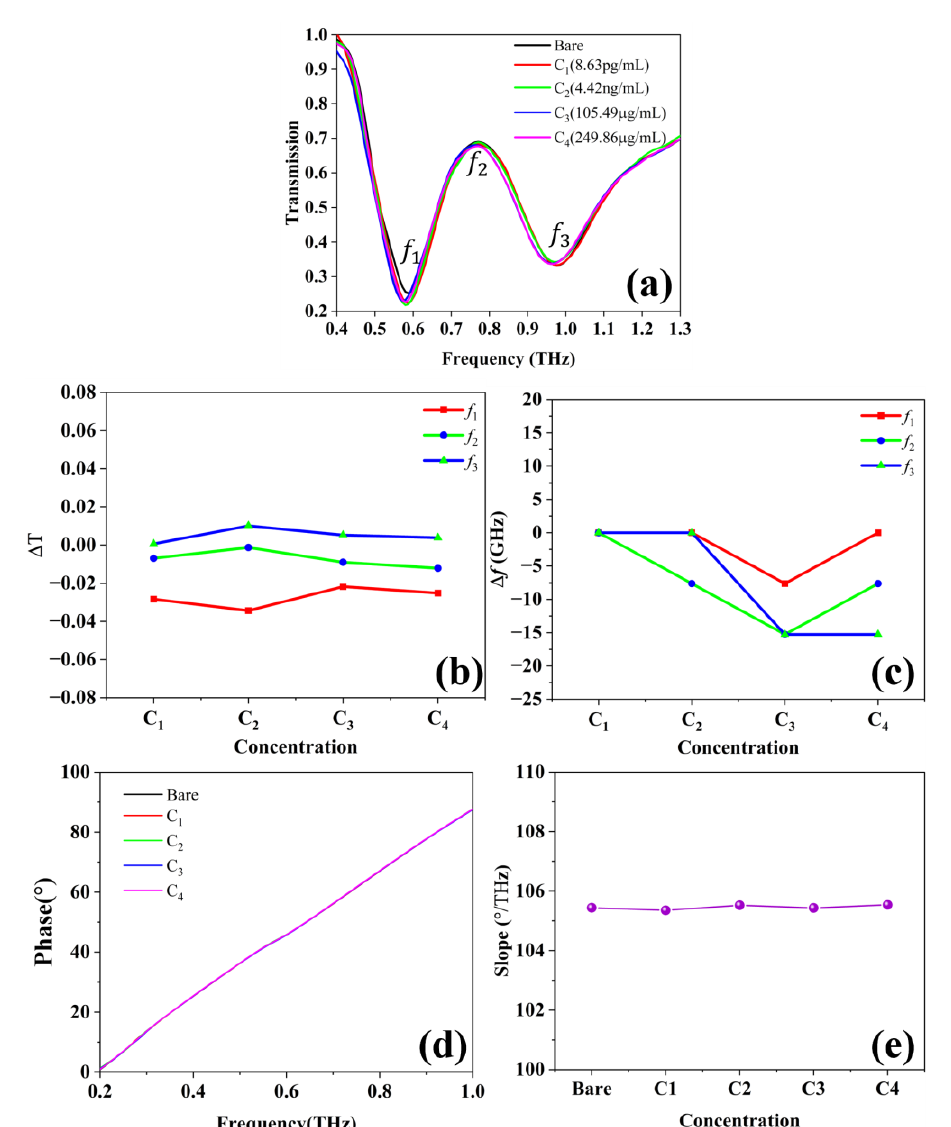
Figure 3. Experimental results of the control group. ( a ) Transmittance spectra of sensors with different concentrations of OVA. ( b ) The amplitude changes of the sensor under the influence of different concentrations of OVA. ( c ) The frequency changes of the sensor under the influence of different concentrations of OVA. ( d ) Phase spectrograms of different OVA concentrations. ( e ) The change in the slope of the phase curve with the concentration of OVA.